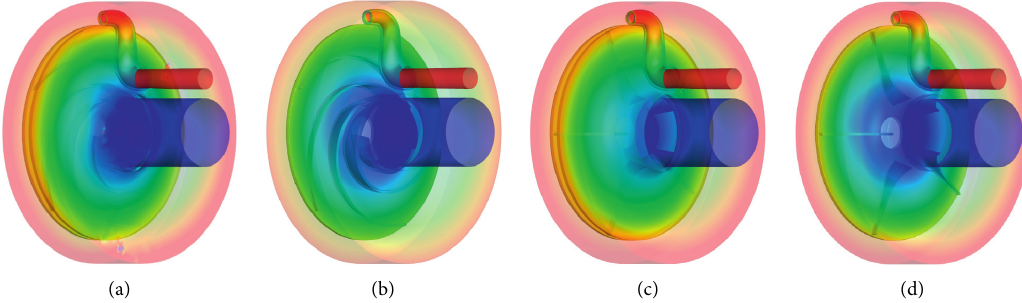
Figure 1: Numerical calculation model of Roto-Jet pump. (a) Model 1. (b) Model 3. (c) Model 5. (d) Model 7.